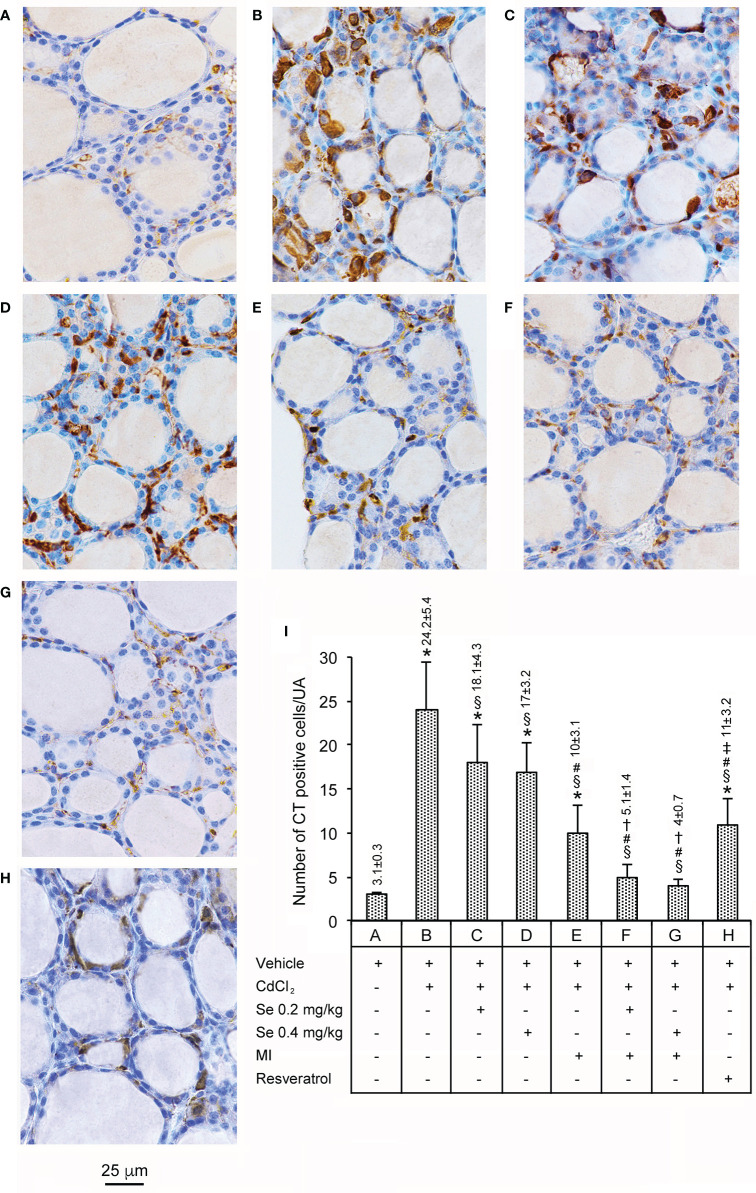
Immunohistochemical expression of CT in the thyroid (Scale bar: 25 µm) in different groups of adult male mice (7 mice/group). Panels and bars are as in
Figure 1
. Panel and bar (A): In controls, only few cells show CT immunoreactivity. Panel and bar (B): CdCl2-treated mice displayed a marked increase of cytoplasmic CT immunoreactivity. Panels and bars (C, D): In CdCl2 plus Se 0.2 mg/kg/day and CdCl2 plus Se 0.4 mg/kg-treated mice, the number of CT positive cells is significantly decreased, but still higher than controls. Panel and bar (E): In CdCl2 plus MI-treated mice, CT positive cells are significantly fewer and show reduced cytoplasmic stain. Panels and bars (F, G): In the thyroid of CdCl2 plus MI and Se at 0.2 or 0.4 mg/kg treated mice, CT immunoreactivity is significantly reduced. Panel and bar (H): In mice treated with CdCl2 plus resveratrol, the number of CT positive cells is significantly decreased, but still higher than controls. Panel (I): Mean number ± standard error of CT positive cells/UA in the different groups of mice. Symbols for statistics *P < 0.05 versus control; §P < 0.05 versus CdCl2 plus vehicle; #P < 0.05 versus CdCl2 plus Se 0.2 and 0.4 mg/kg; †P < 0.05 versus CdCl2 plus MI; ‡P < 0.05 versus CdCl2 plus MI plus 0.2 mg/kg Se and CdCl2 plus MI plus 0.4 mg/kg Se.